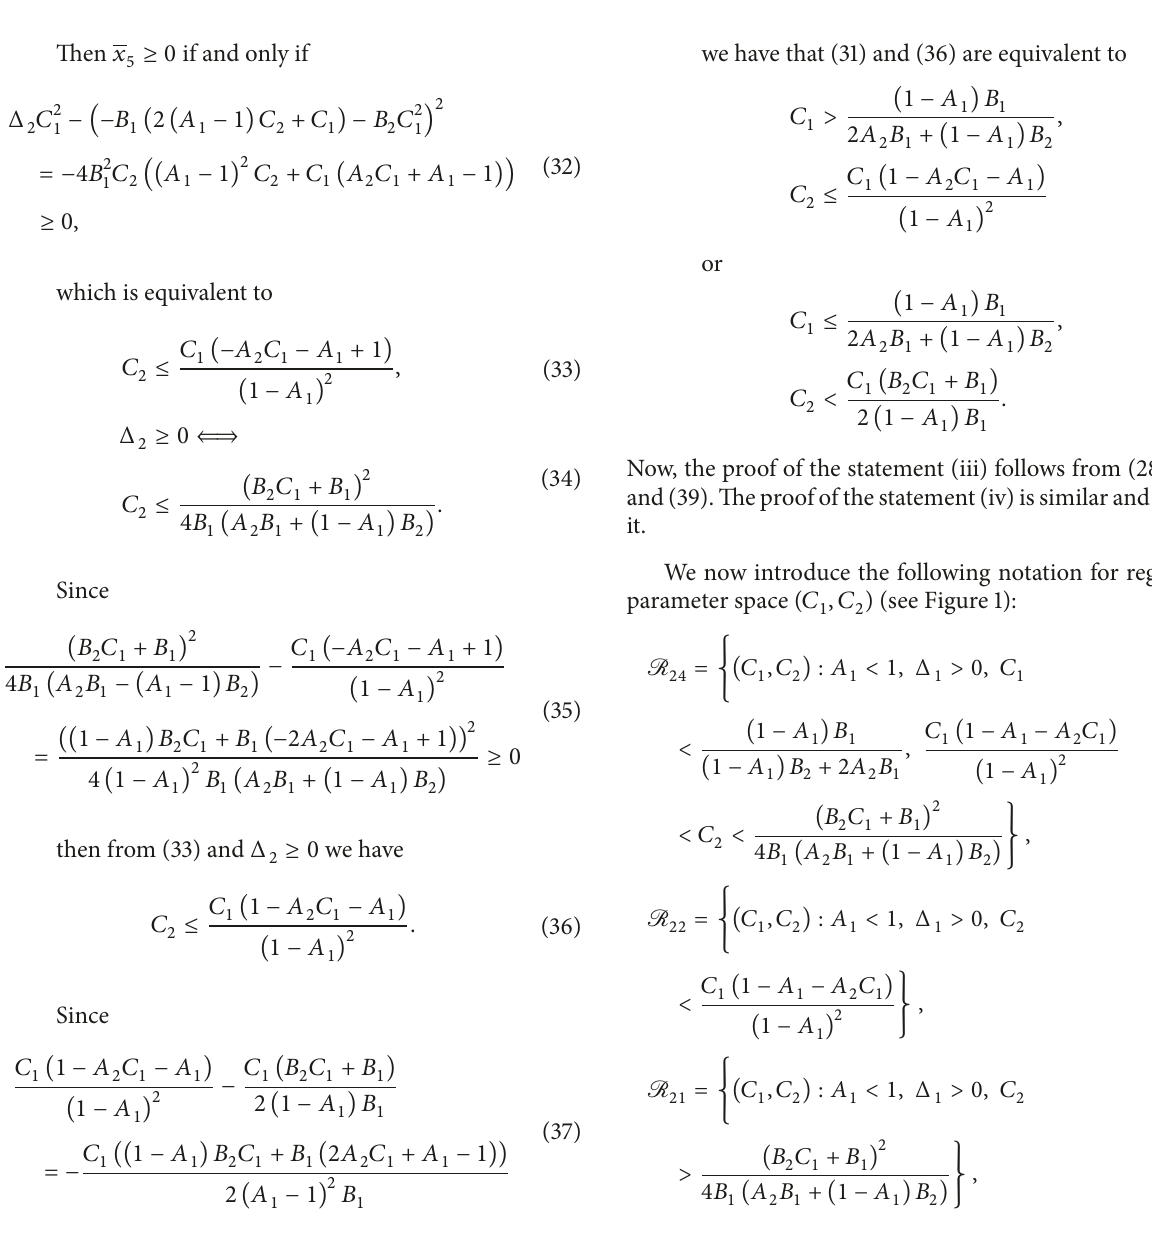
C 32 and 31 are defined as part of the parabola